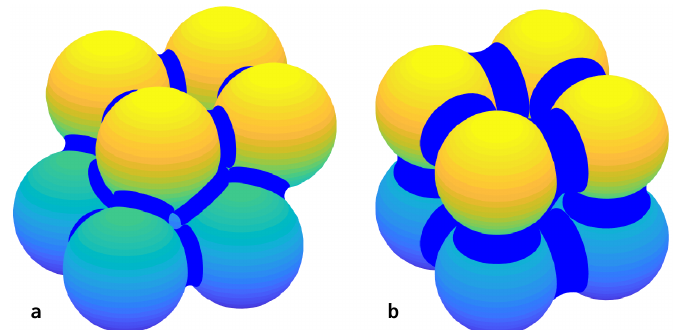
Figure 1. 3D illustration of s h = 25% of hydrate in a meniscus shape between grain contacts of ( a ) pyramidal and ( b ) simple-cubic sphere packings.